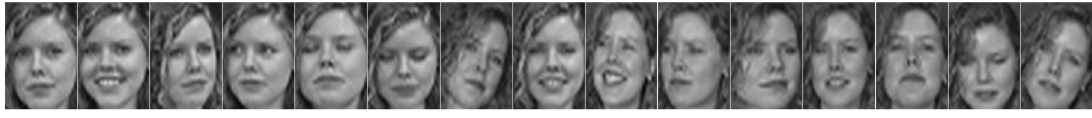
Figure 3. Sample face images of GT face database.